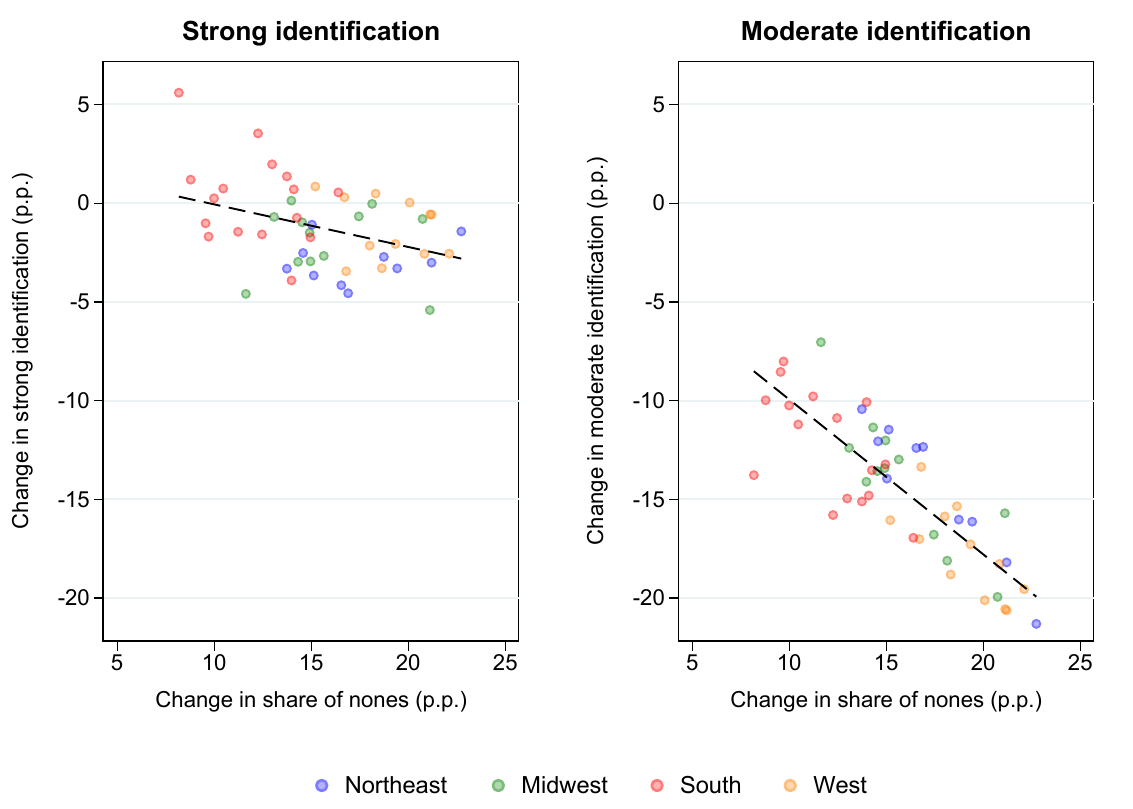
Figure 5: State-level trends in the share of religious nones and strength of religious identification, 1990 to 2018. Notes: All axes are measured in percentage points (p.p.). The dashed lines depict the best-fitting lines. The correlation coefficient for the left panel equals − 0.38; the correlation coefficient for the right panel equals − 0.83. Utah, as an outlier, has been omitted from both graphs; its coordinates are ( 22, − 10 ) for the left panel and ( 22, − 13 ) for the right panel. An interactive version of this figure is available